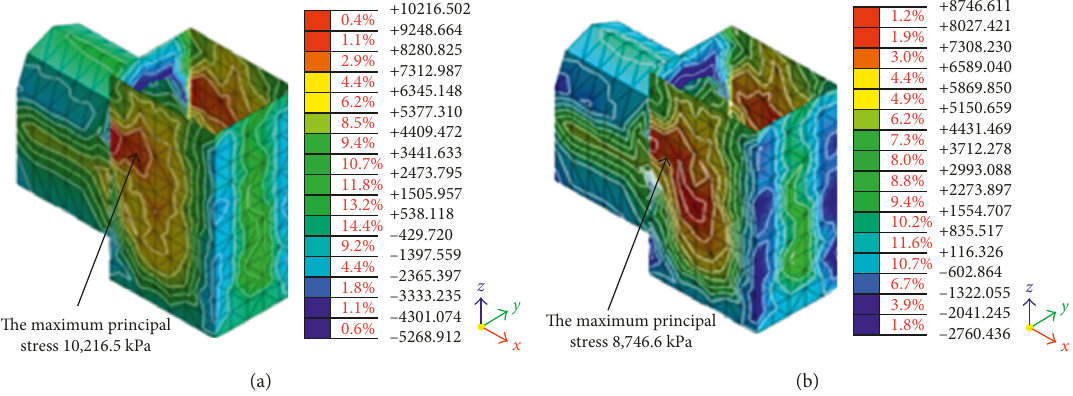
Figure 10: Maximum principal stress distribution in the horsehead. (a) Method 1. (b) Method 2.